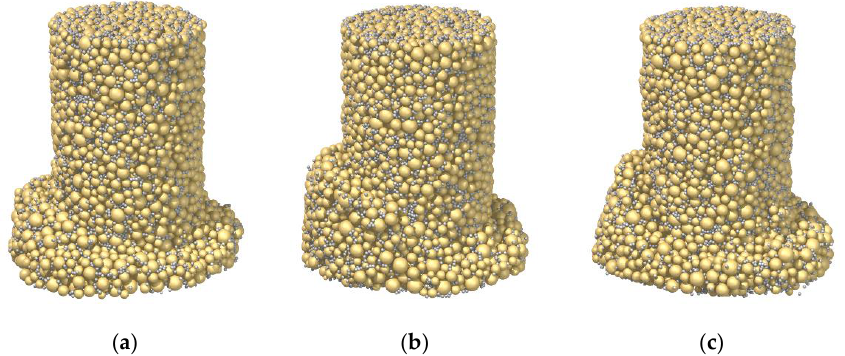
Figure 8. Influence of the initial void ratio on the failure mode: ( a ) Sample C28_R5L; ( b ) Sample C28_R5M; ( c ) Sample C28_R5D.